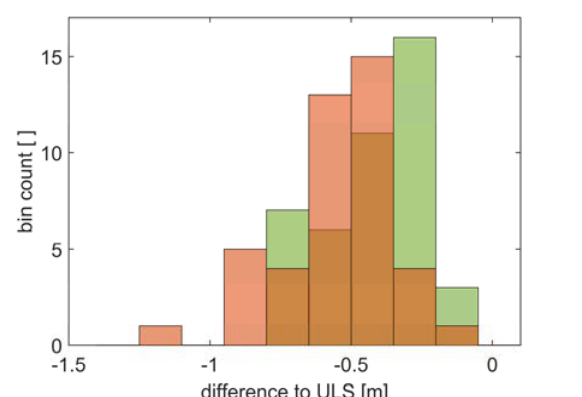
Figure 9. Histogram of penetration depth for shrubs; red: ULS to ALS; green: ULS to ALB; brown: transparent overlaying